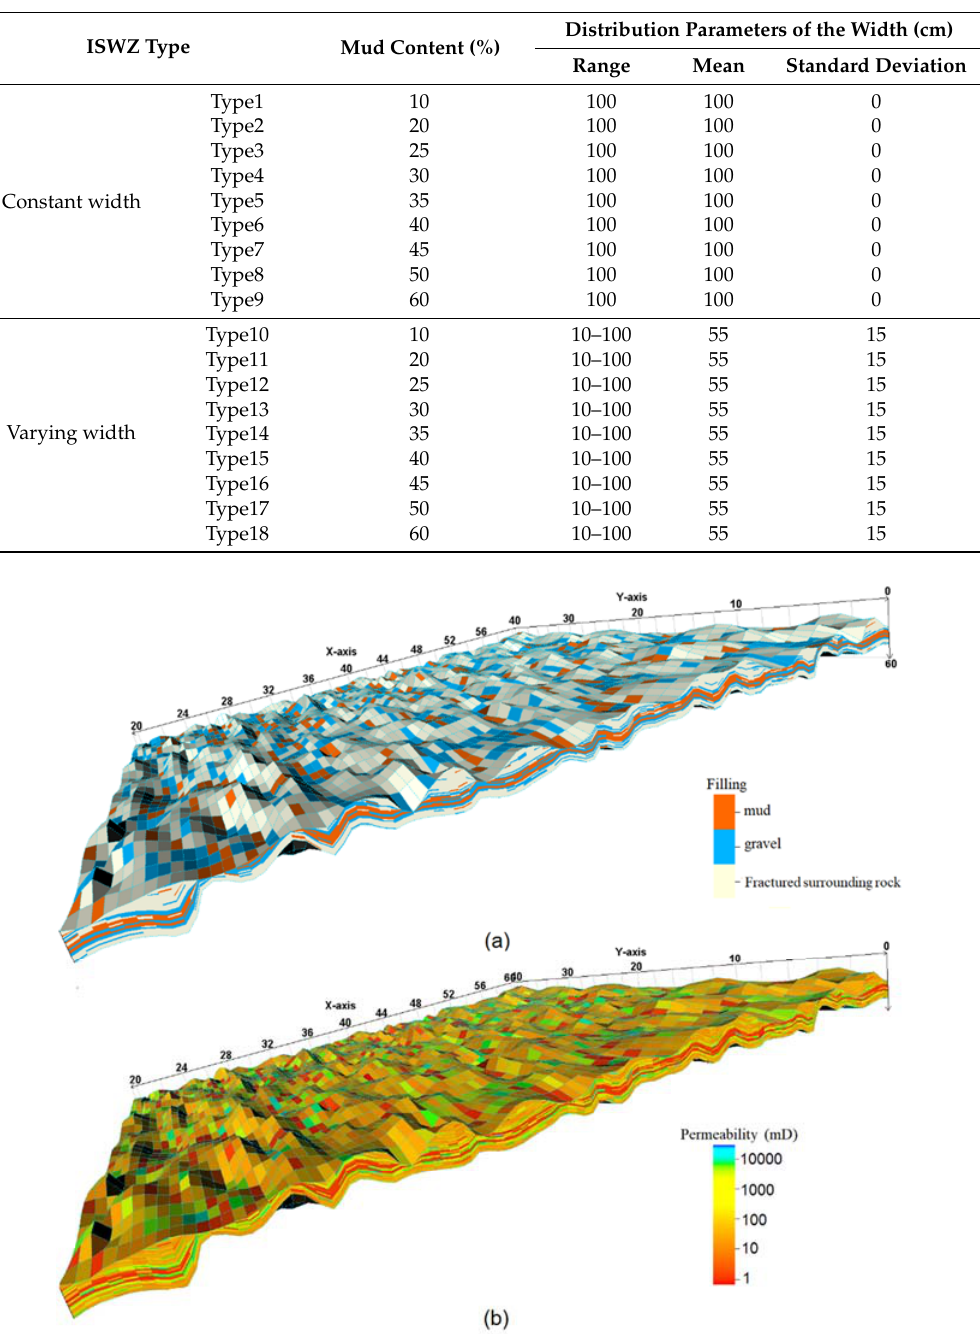
Table 3. Main geometry parameters for all the studied ISWZs. Distribution Parameters of the Width (cm) ISWZ Type Mud Content (%) Range